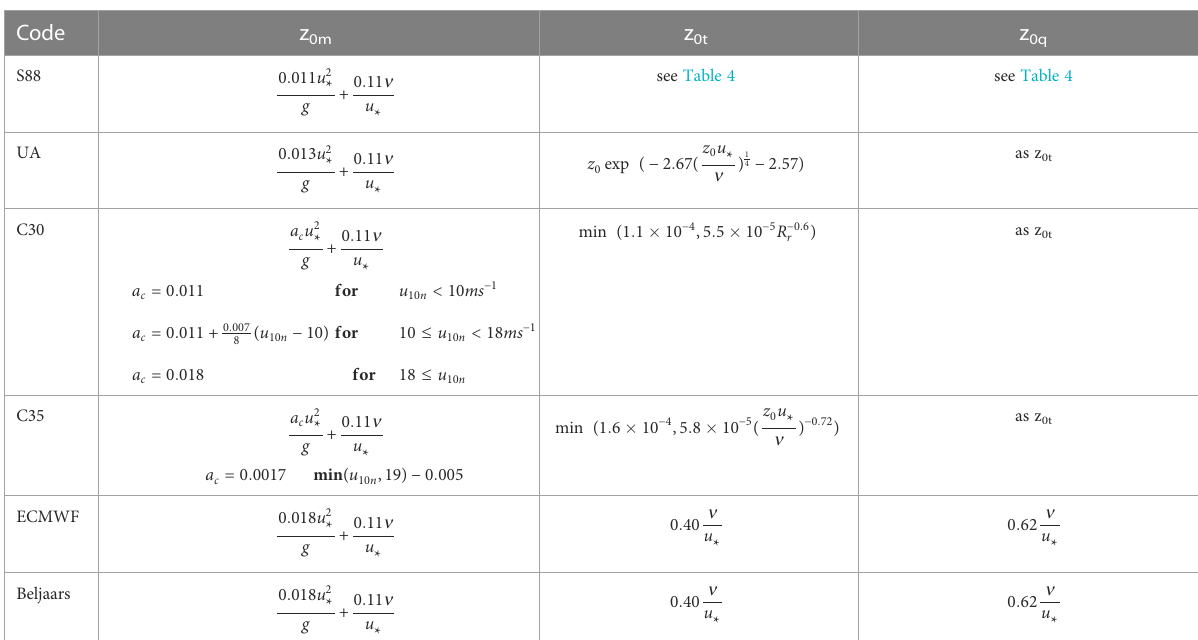
TABLE 5 Parameterizations de fi ned in terms of the roughness